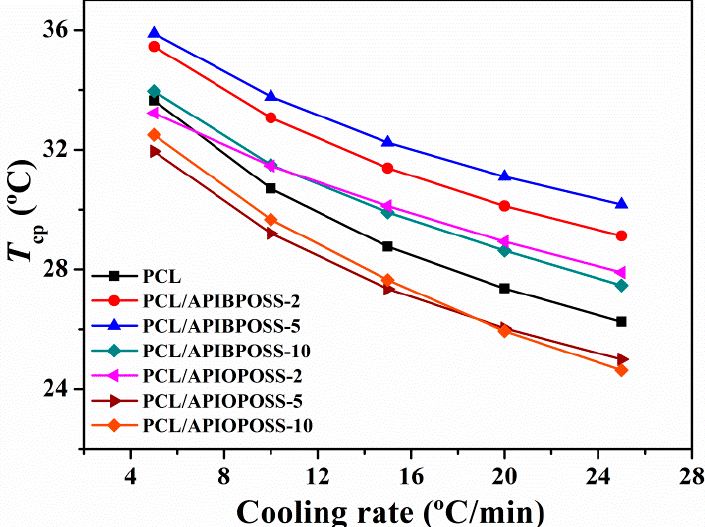
Figure 2. Crystallization peak temperatures as a function of cooling rate for PCL and PCL/polyhedral oligomeric silsesquioxanes (POSS) nanocomposites.